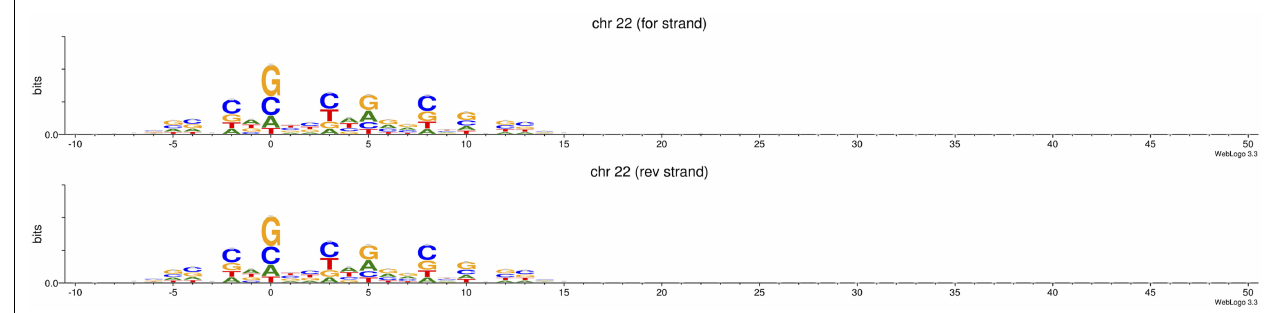
Fr ontiers in Bioengineering and Biotechnology |